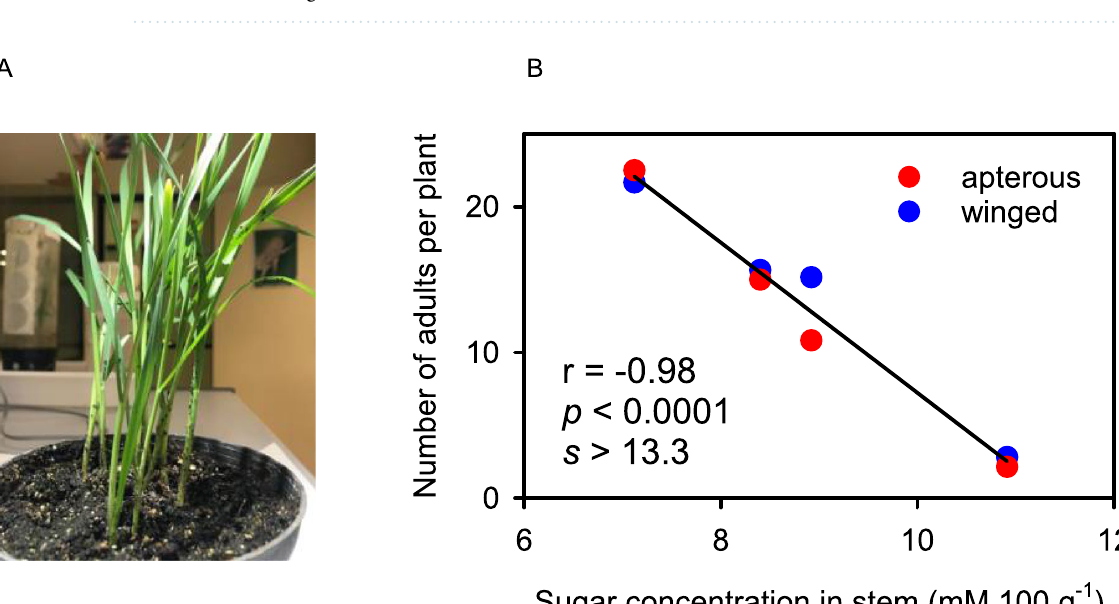
Figure 8. ( A ) Rophalosiphon padi established and fed preferentially in the basal part of the plant. ( B ) Number of R. padi adults (winged and apterous) declined with increasing molar concentration of sugars in wheat stem, assay 3. The line is the least-square